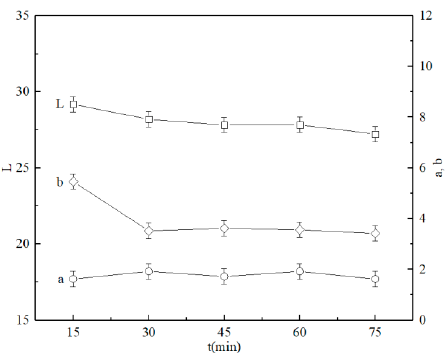
Figure 12. Effects of sintering time on the coloration of ceramic tiles with Fe / Cr = 2.0 sintered at 1150 ◦ C.